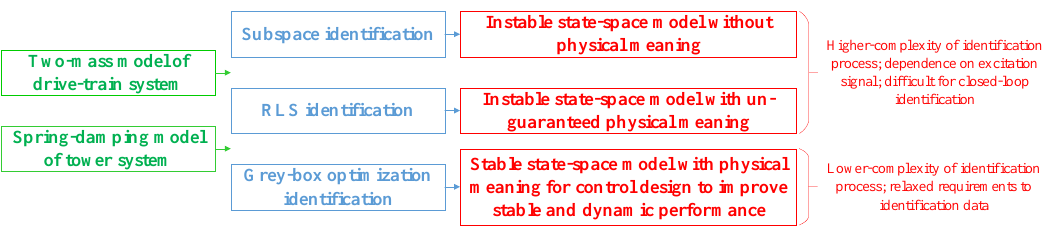
Energies 2019 , 04 , x FOR PEER REVIEW 23 of 26 Table 8. Comparison analyses of identification results for tower model. Identification Methods Identification Condition Herein